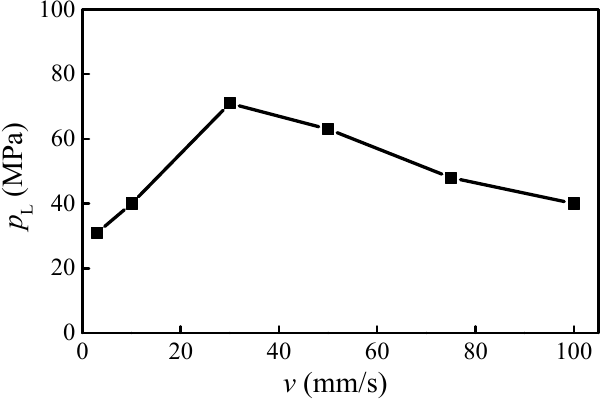
Figure 14. Influence of the loading rate on high-pressure zones.